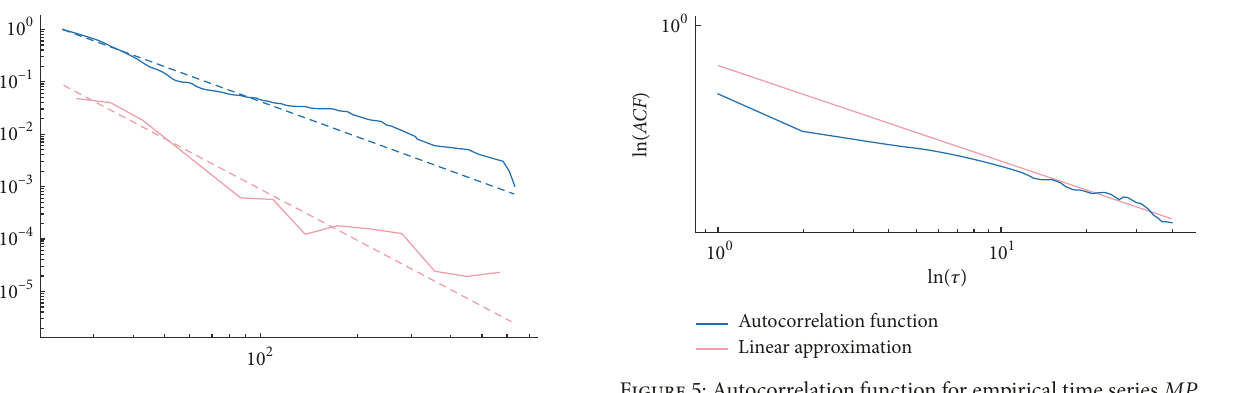
Figure 5: Autocorrelation function for empirical time series 𝑀𝑃 𝑡